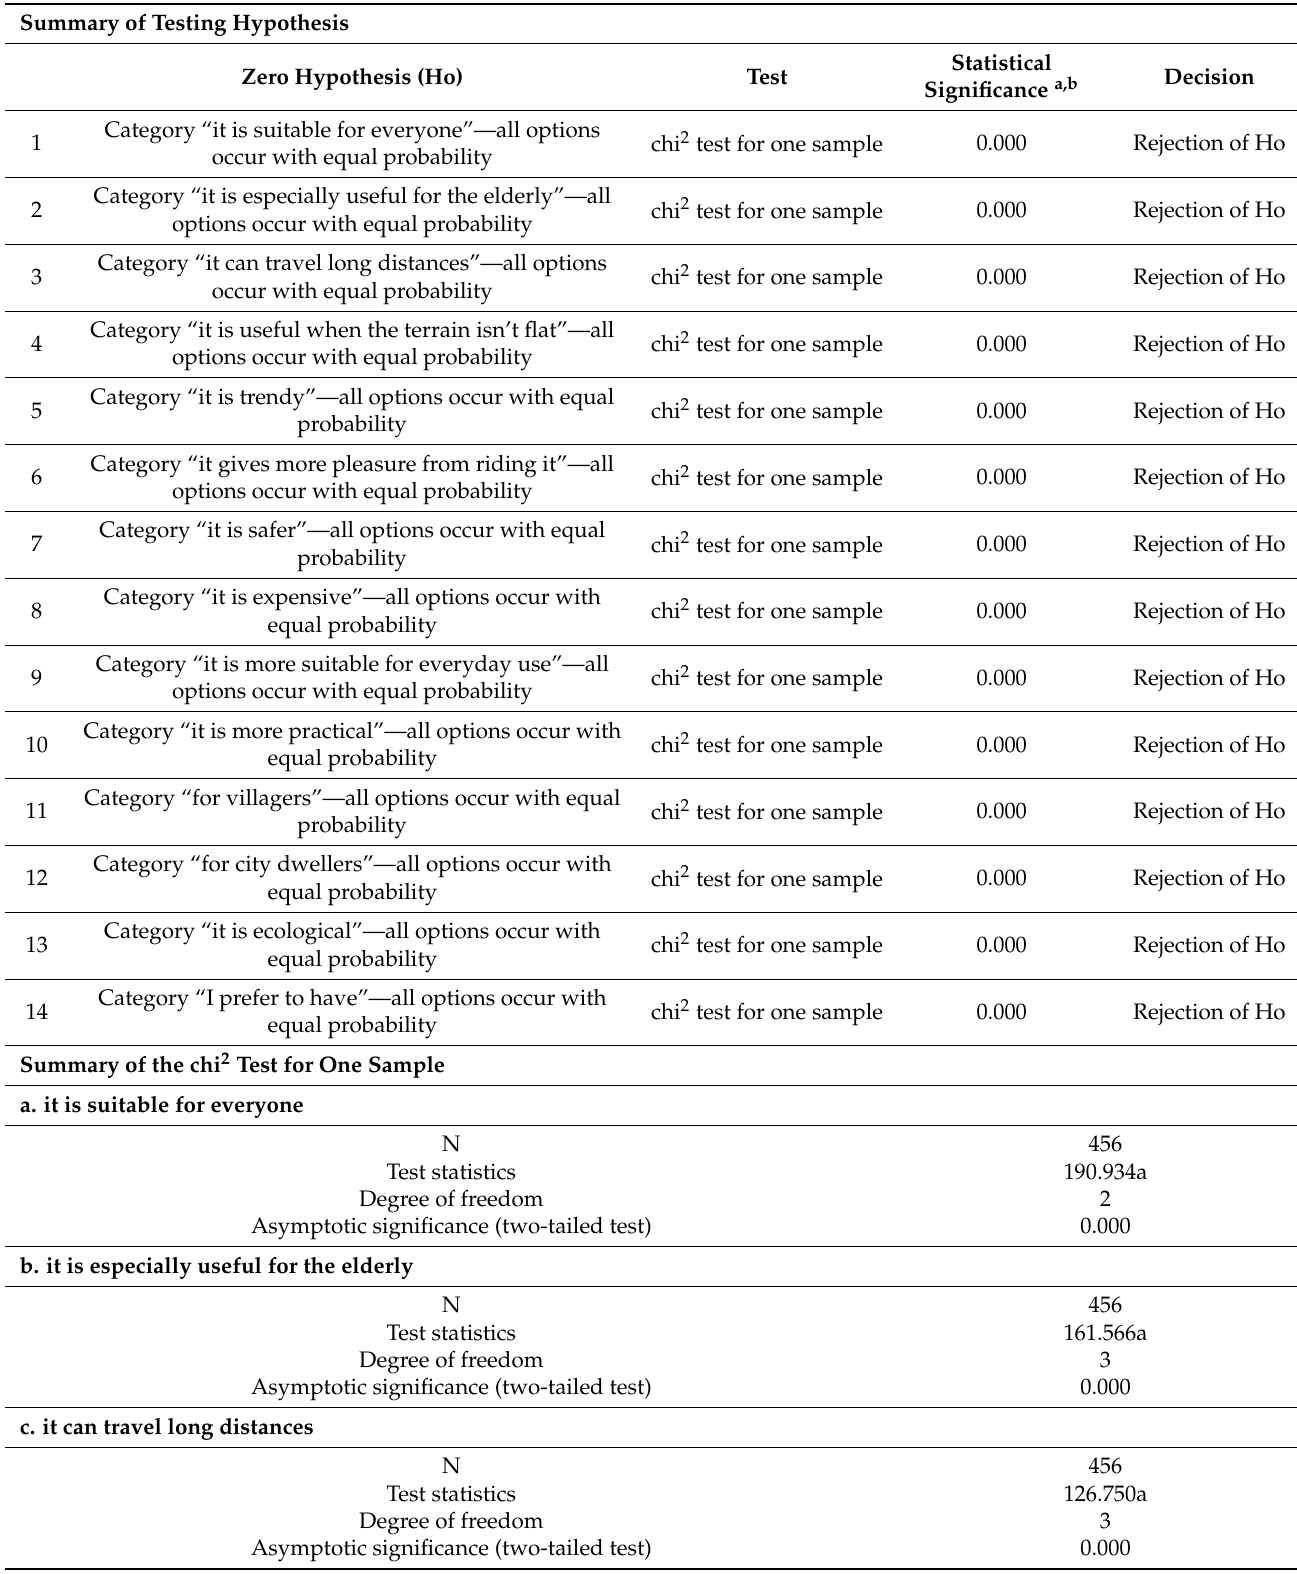
Table A4. Results of the non-parametric chi 2 test for the question: “Which of the options listed below best fits the characteristics